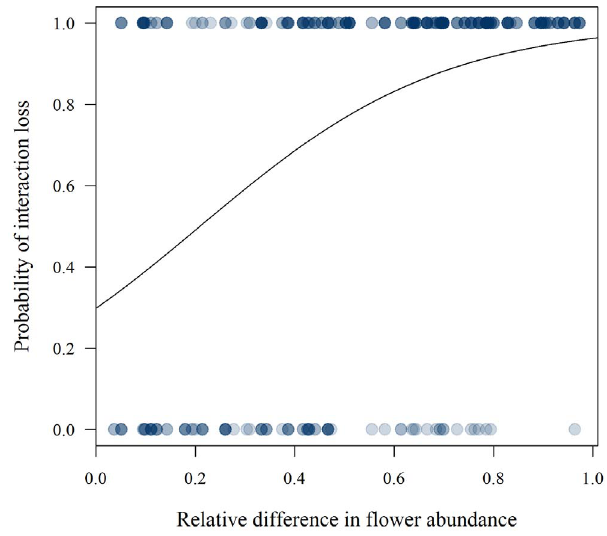
Figure 3. Interaction frequency and interaction turnover. Average interaction frequency is negatively related to the probability of interaction turnover. The more frequent interactions show lower probabilities of turnover between sites. Superimposed points result in darker marks.